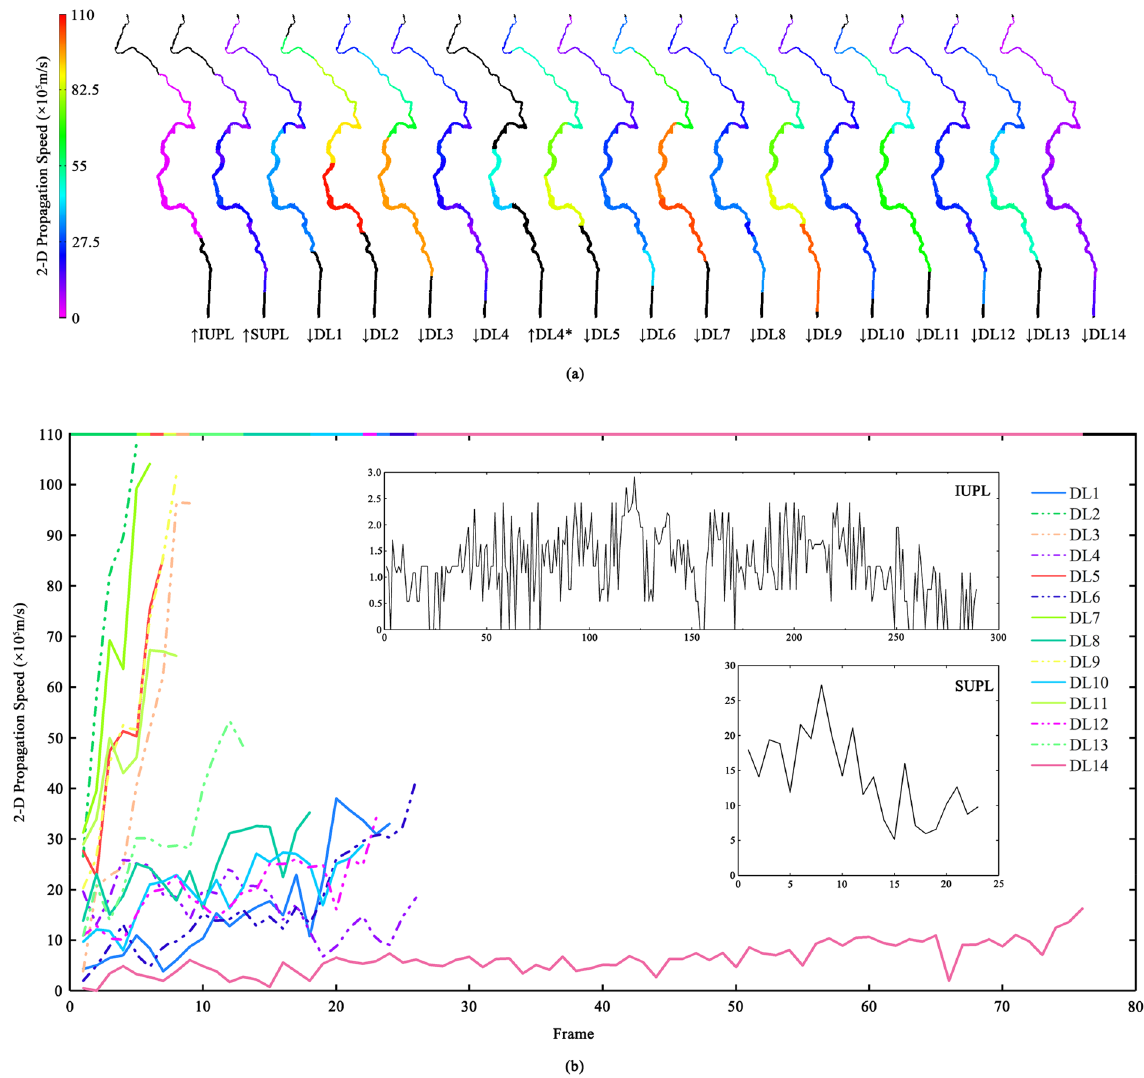
Figure 7. Propagation speeds variations of sixteen leaders in F1907021515. ( a ) The speed-position figure of sixteen leaders. The arrow preceding ID of each leader indicates the propagation direction. The upward propagation of bidirectional leader DL4 is also shown. ( b ) The propagation speeds variations of sixteen leaders. Only the downward propagation of bidirectional leader DL4 is shown. The top border is colored to show the duration of each